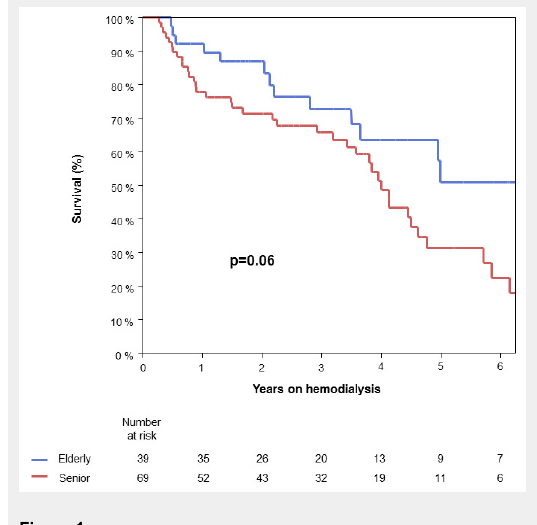
Patient survival The abscissa shows years after the start of haemodialysis and the ordinate shows patient survival as a percentage.